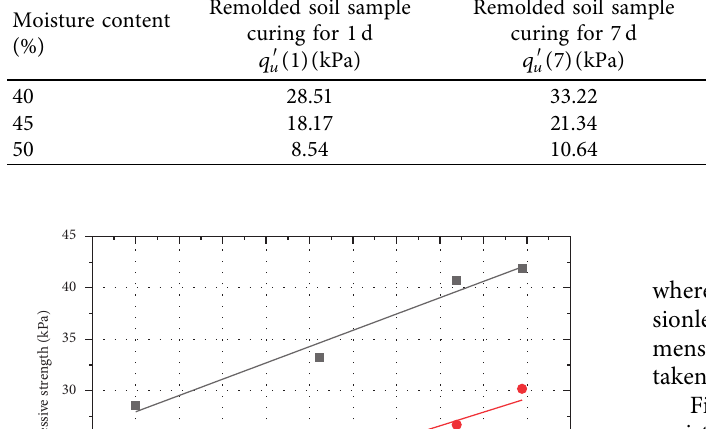
Table 3: Unconfined compressive strength of remolded samples with different moisture contents at different curing times. Moisture content (%)